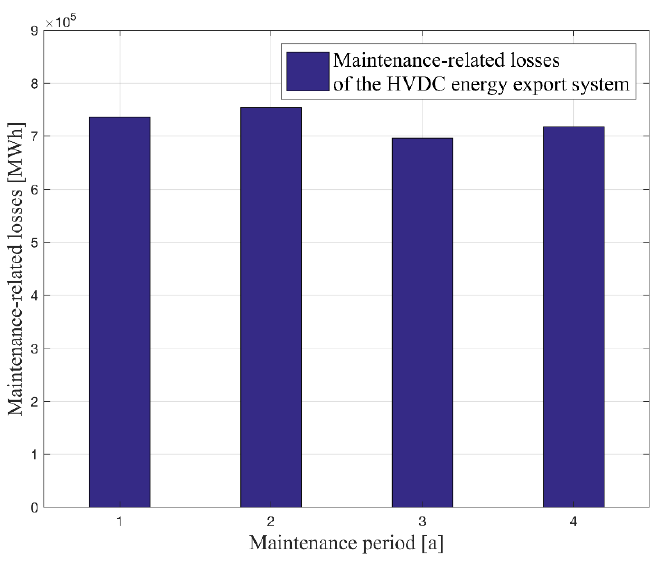
Figure 10. Maintenance-related losses for the total operation time of the HVDC system over di ff erent maintenance periods.